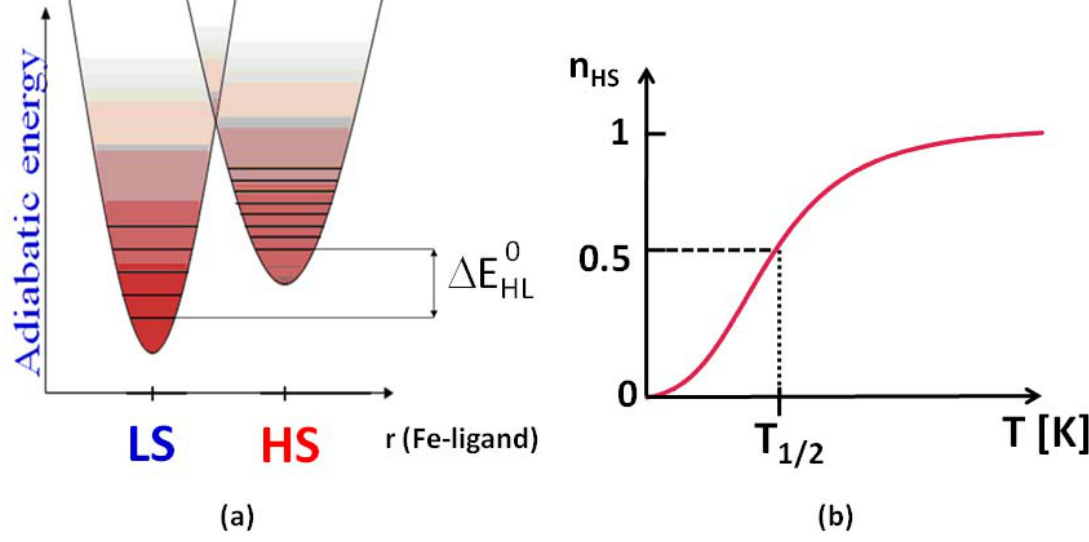
Figure 1. ( a ) Jablonski diagram for SCO molecules with adiabatic energy vs . Fe-ligand distance; ( b ) n vs . T profile for a gradual SCO HS